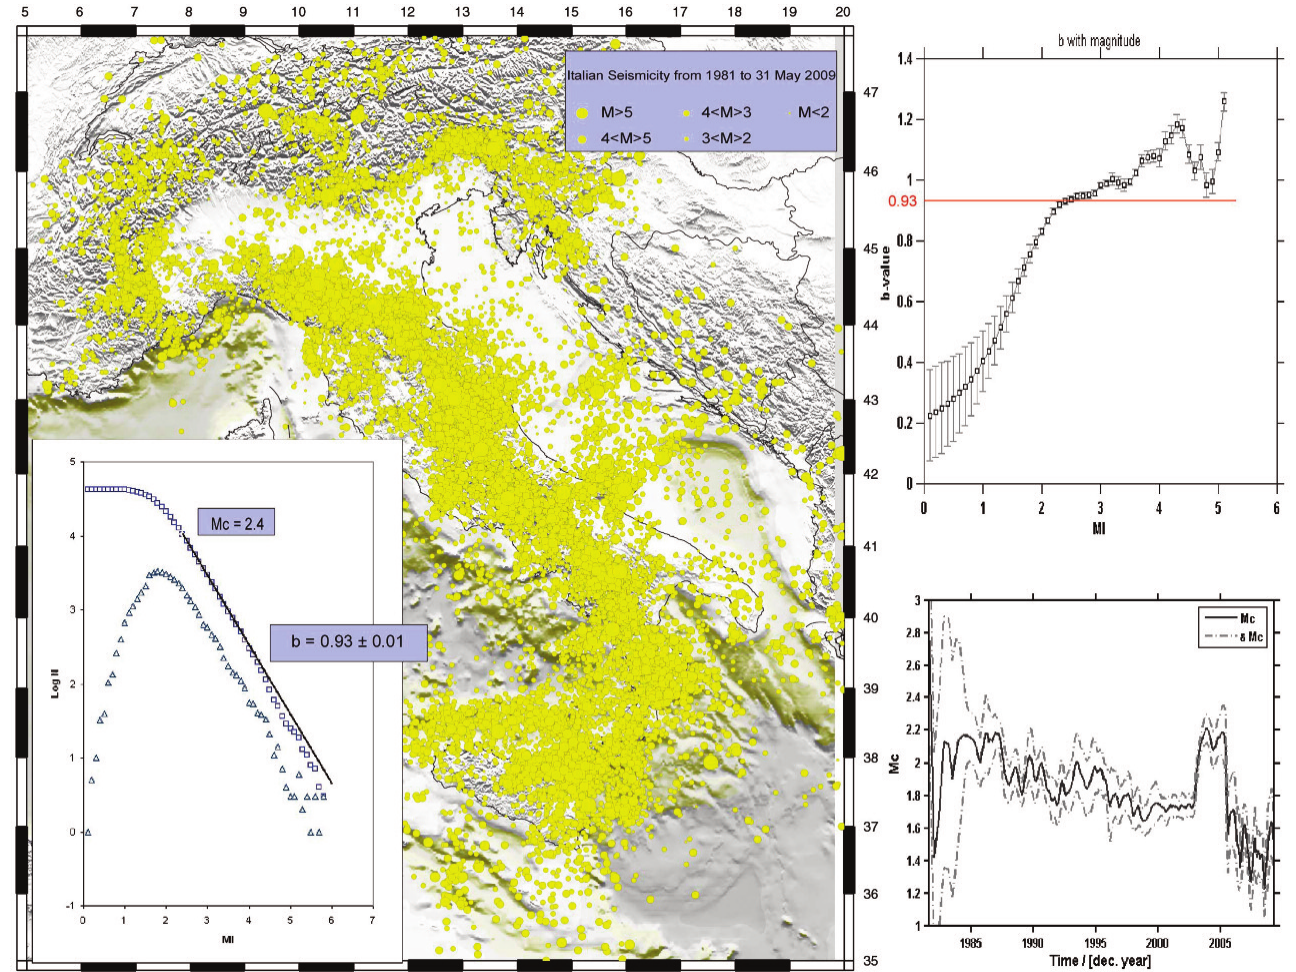
Figure 1. Left: Italian seismicity from 1981 to May 31, 2009, with the frequency-magnitude distribution (squares, cumulative; triangles, not-cumulative) obtained for the overall merged catalog adopted for the ALM and HALM. Right: The b -value as a function of the magnitude cut-off (top; red line, adopted b -value), and the magnitude of completeness as a function of time (bottom; sample size, 500